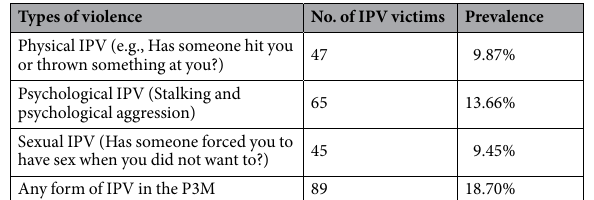
Table 1. Prevalence of IPV among MSM at baseline (N = 476). Abbreviations: IPV = intimate partner violence; P3M = past three